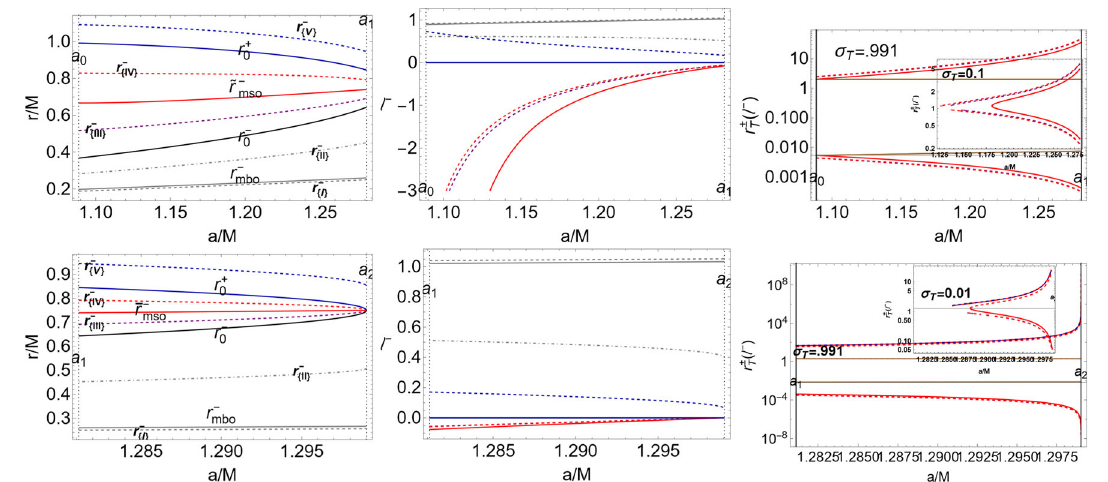
Fig. 2 Analysis of the flow inversion point radius r ± (cid:2) with fluid spe- cific angular momentum (cid:6) = (cid:6) − . (For (cid:6) − > 0 inversion points are only for spacelike particles with ( E < 0 , L < 0 ) .) Spins { a 0 , a 1 , a 2 } are defined in Table 2. Radii r − mso = {¯ r − mso , ˜ r − mso } are the marginally stable orbit, radius r mbo is the marginally bounded orbit. There is σ ≡ sin 2 θ ( σ = 1 is the equatorial plane). There is r ± the test particle angular momentum and r ± δ : E = 0 where E is the